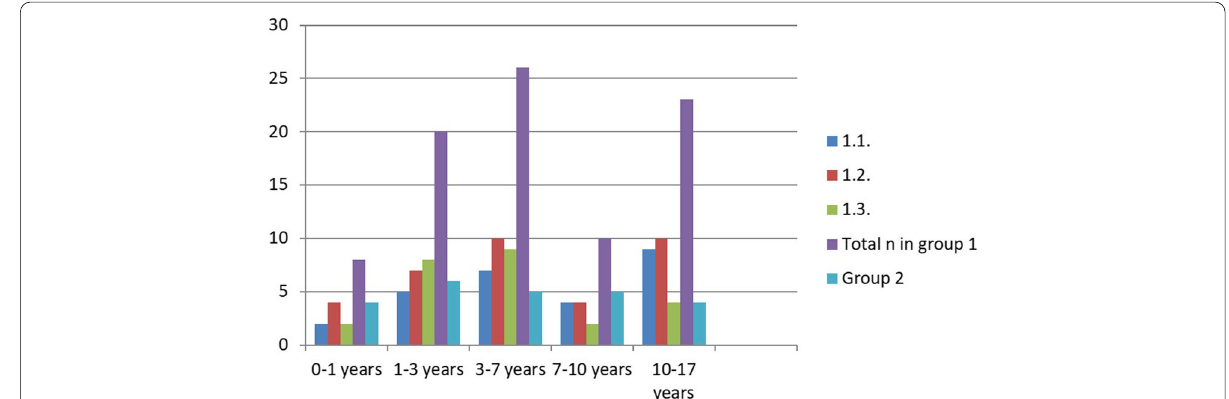
Fig. 3 Age distribution diagram of operated patients according to different groups and subgroups